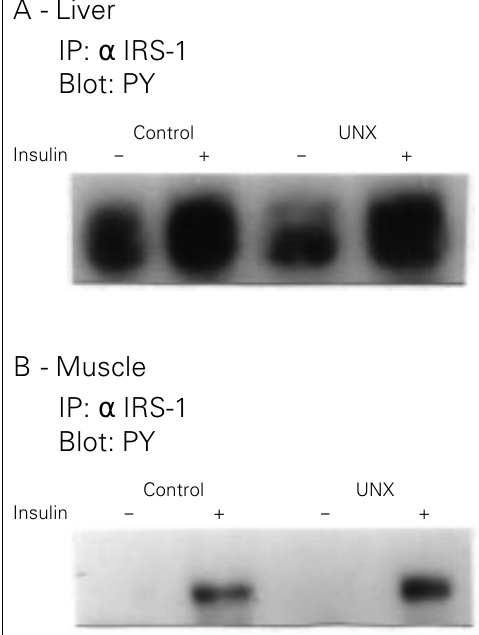
Figure 2 - Effect of unilat- eral nephrectomy (UNX) on insulin receptor substrate 1 (IRS-1) in the rat liver and muscle. The liver extracts from controls and unilater- ally nephrectomized rats were immunoprecipitated (IP) with anti-IRS-1 antibody ( a IRS-1) and then immuno- blotted (Blot) with anti- phosphotyrosine antibody (PY) (A). The same proce- dure was applied to muscle